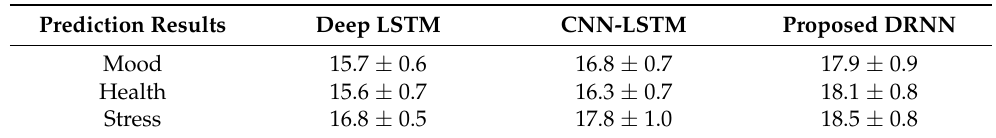
Table 4. Mood, health, and stress prediction outcomes of existing and proposed classification